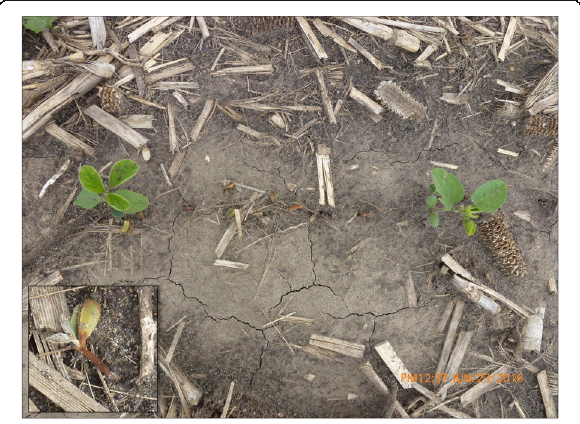
Fig. 1 Field symptoms of Pythium damping-off observed during